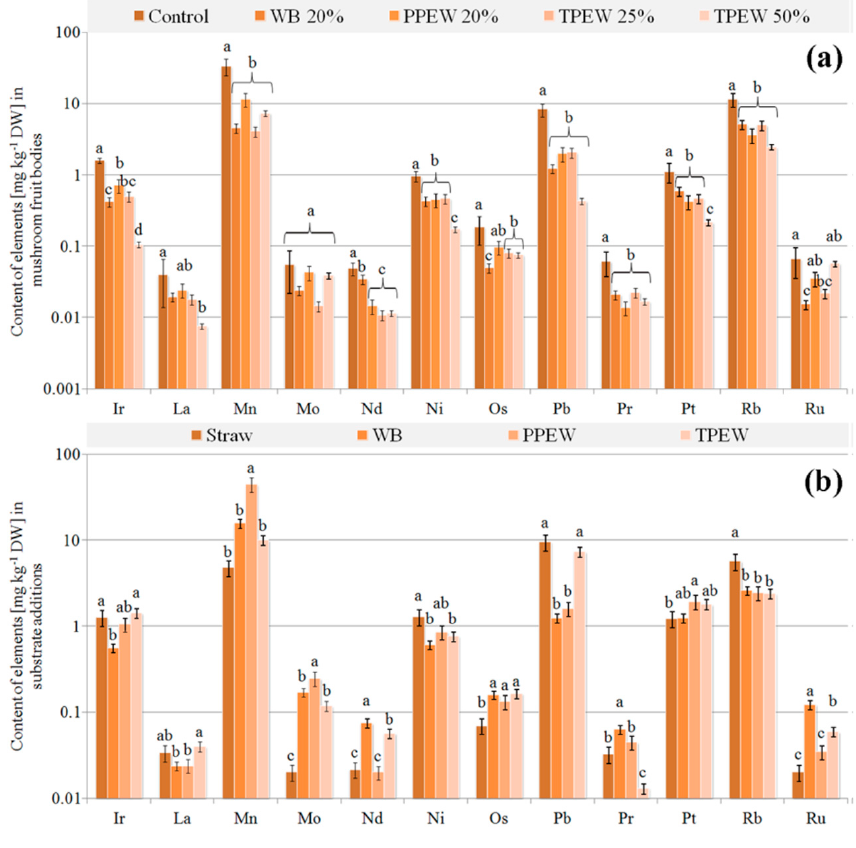
Figure 4. Content of trace elements (mg kg − 1 DM) in Pleurotus citrinopileatus fruit bodies ( a ) and particular additions included to substrate ( b ). Mean values ( n = 3); identical superscripts ( a–d ) denote no significant ( p < 0.05) difference between mean values in columns according to Tukey’s HSD test (ANOVA) for mushrooms growing at particular substrates. WB—wheat bran, PPEW—pumpkin post-extraction waste, TPEW—thymus post-extraction waste.